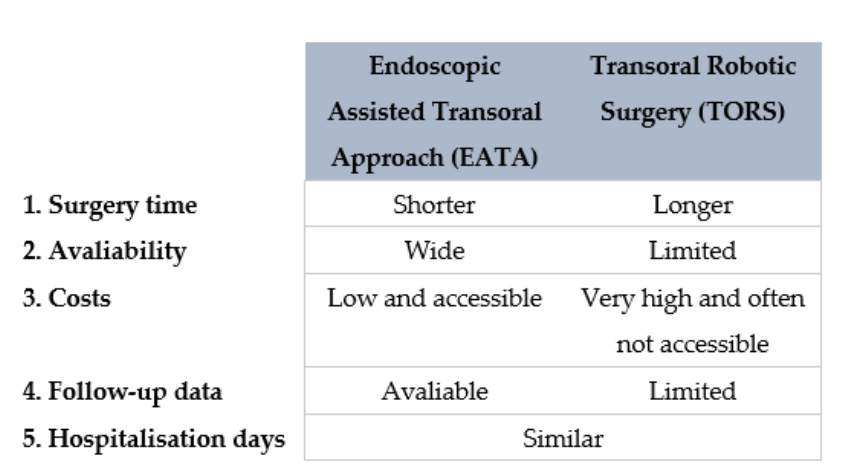
Figure 9. Diagram comparing EATA and TORS.